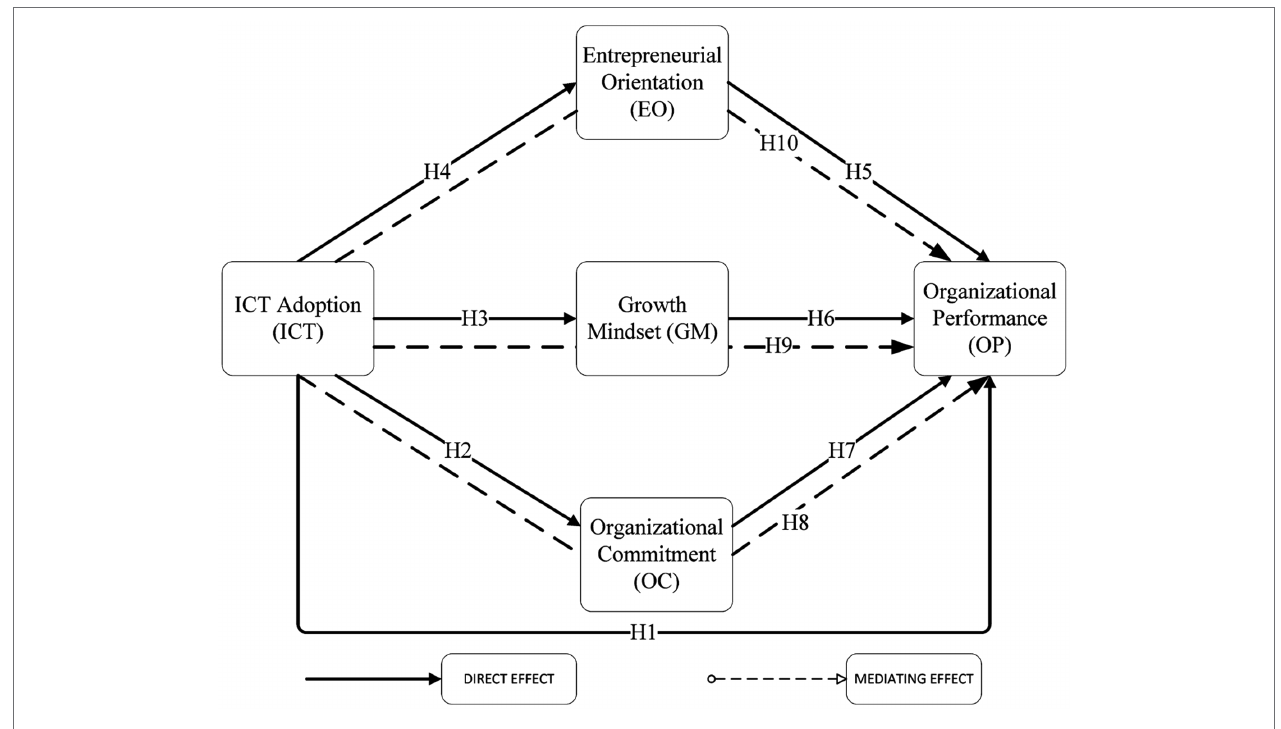
FIGURE 1 | The proposed theoretical framework.